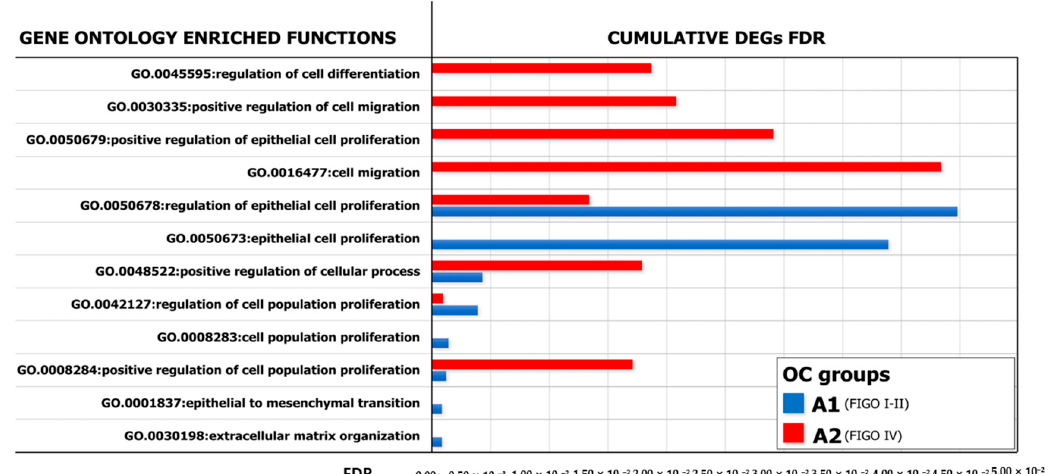
Figure 6. GO analysis of enriched biological processes. Representation of the Gene Ontology (GO) enriched functions (FDR < 0.05) revealed in A2780, conditioned by ML-Ddx4 + cells from either early- (blue) or advanced- (red) stage NS-EOC. The analysis showed di ff erences in the extent of several biological processes, as induced by the two models of OC. In particular, functional enrichment analysis applied to DEGs identified that, in both patient groups, genes in the “biological process” GO category were significantly enriched in the terms “regulation of cell population proliferation”, “regulation of epithelial cell proliferation”, “extracellular matrix organization”, “cellular component organization” and “regulation of cell di ff erentiation and cellular